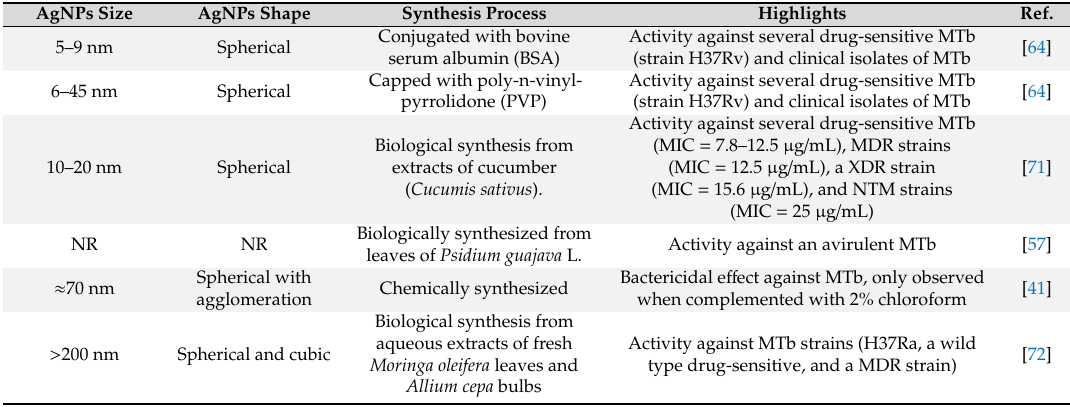
Table 2. AgNPs with reported activity against Mycobacterium tuberculosis